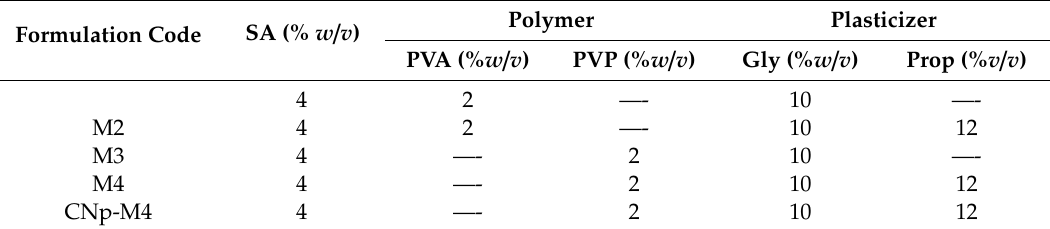
Table 1. Formulation of alginate membranes with di ff erent polymers as plasticizers. PVA: poly